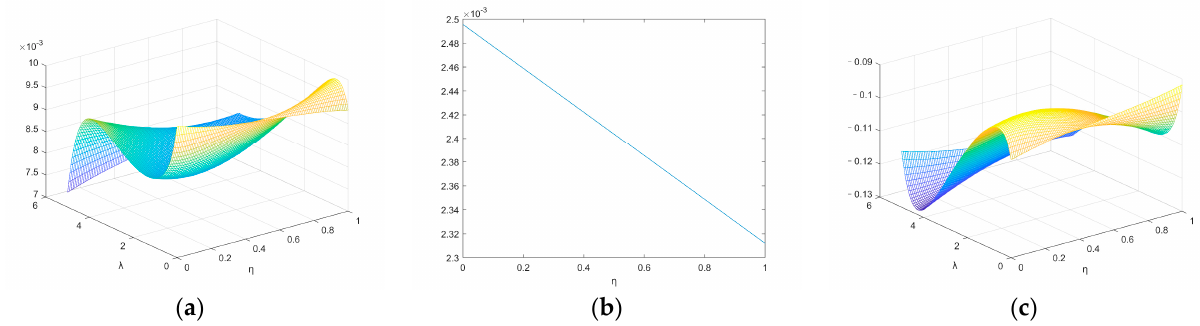
Figure 2. Individual utilities under the DC model are: ( a ) M’s profit in the DC model; ( b ) L’s utility in the DC model; ( c ) F’s utility in the DC model.